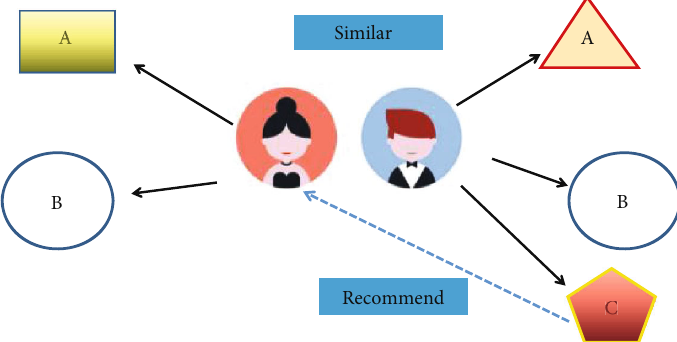
Figure 2: The principle of CF algorithm.